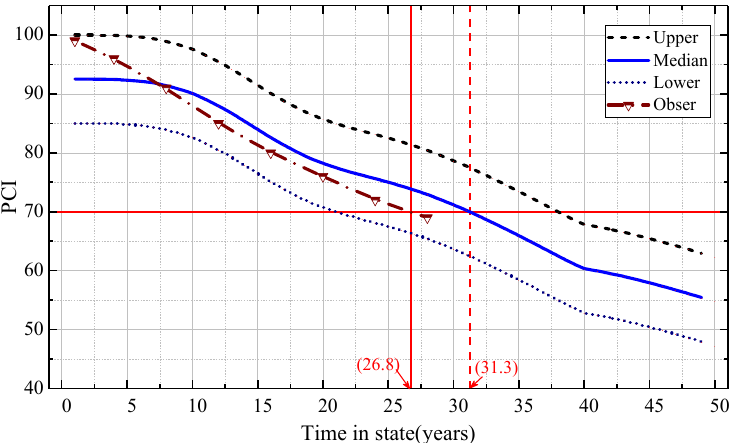
Figure 6. PCI prediction of the Markov model for airport pavement sample Data2S22.